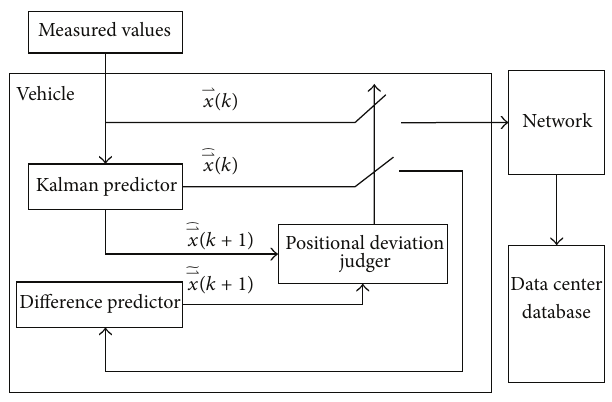
Figure 2: The vehicle position updating